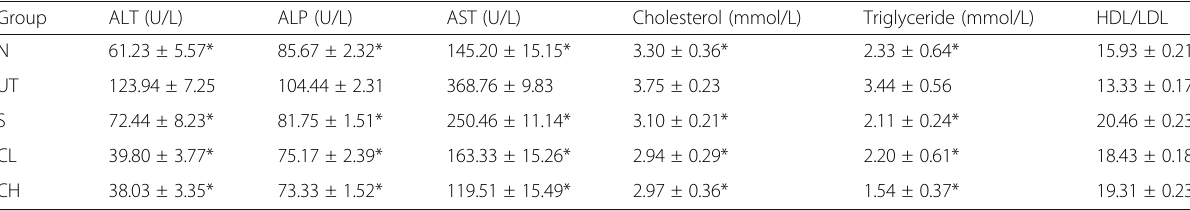
The data presented were representative as mean±SD of biological replicated of mice from the same treatment group. Significant values were calculated against untreated group (* P